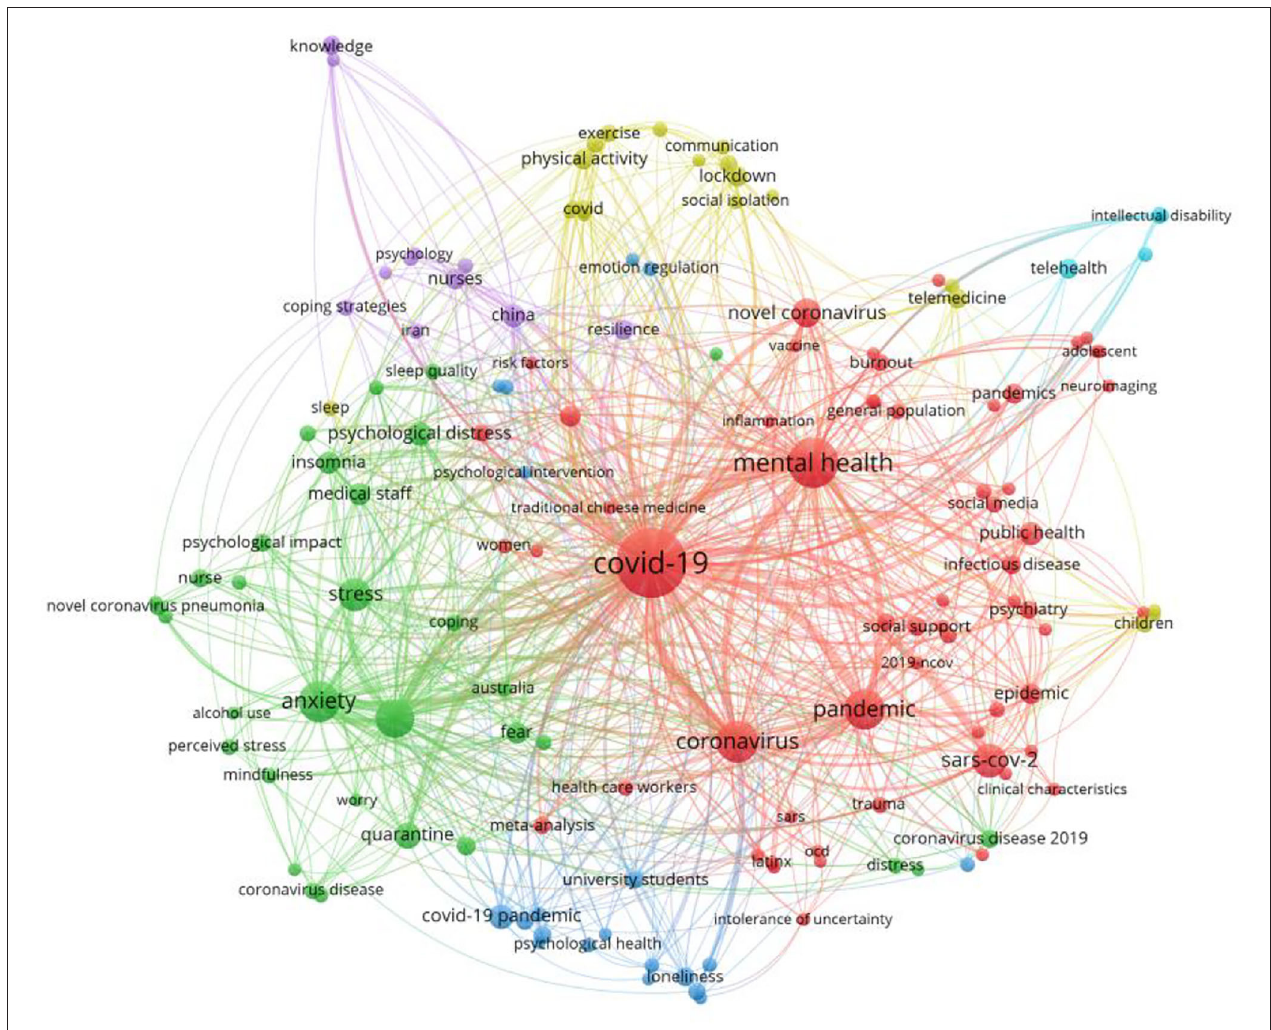
FIGURE 6 | Keyword